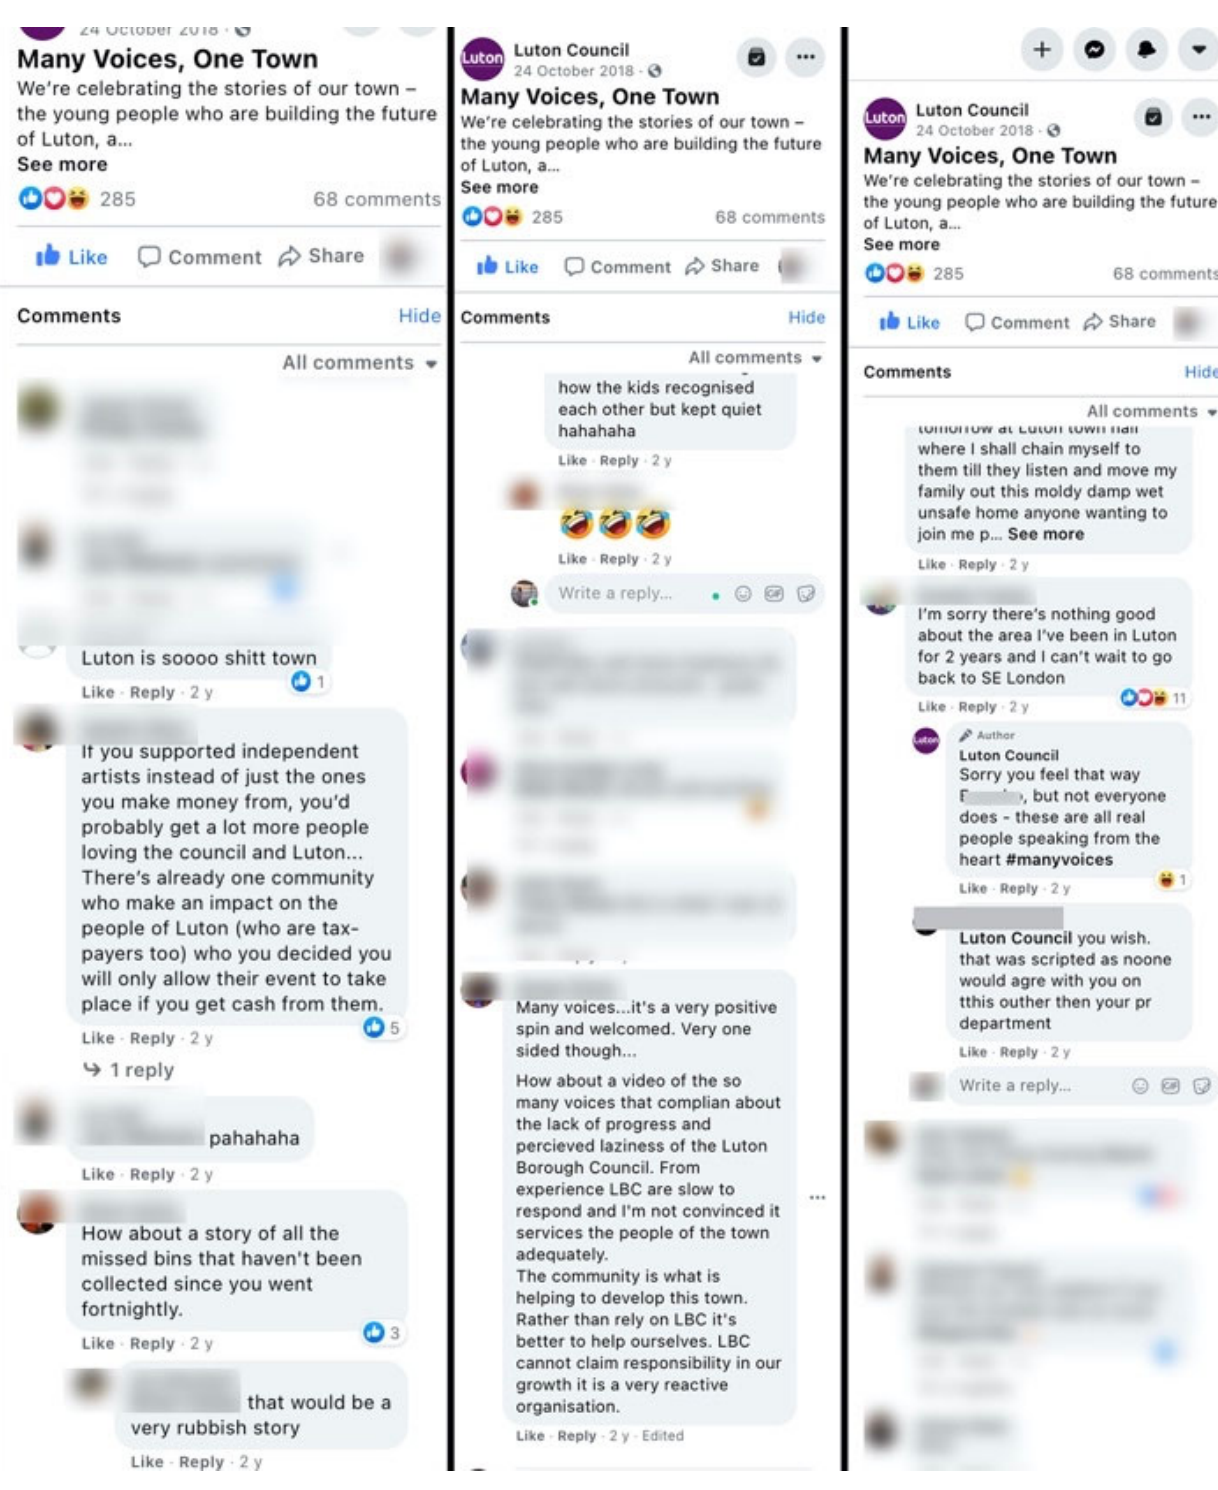
Figure 2. Many Voices One Town negativity expressed in comments (netnographic data from